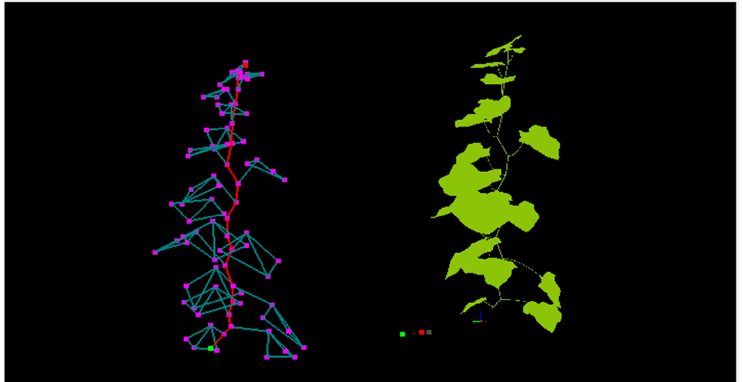
Figure 2. The skeleton model ( left ) and a virtual model filled with leaf shaped samples ( right ) of a cucumber plant from digitized data produced by the software program “Visualization and 3D Reconstruction of Plant Models”.